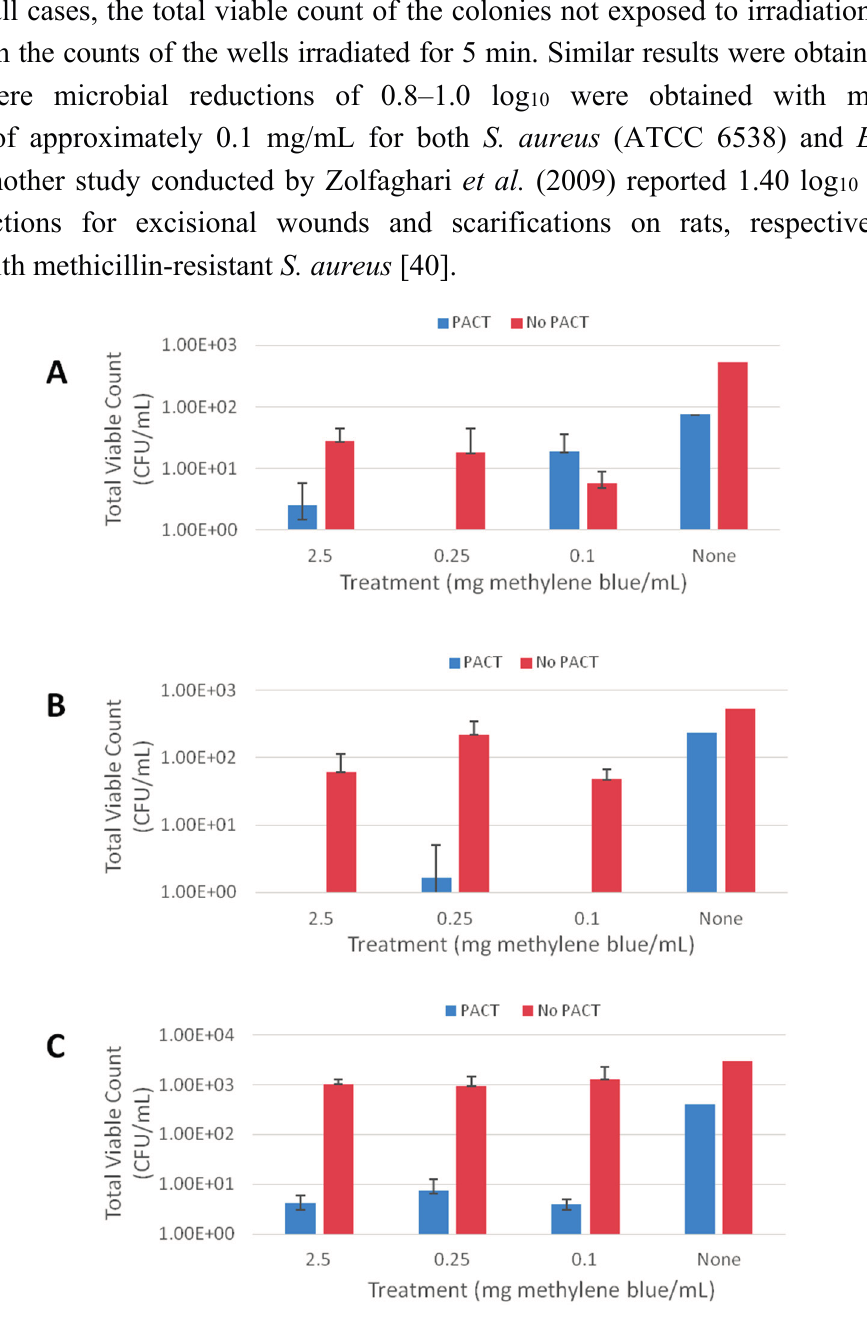
Figure 4. Effect of exposure to photodynamic antimicrobial chemotherapy (PACT) at a range of methylene blue concentrations on killing of biofilm grown strains ( A ) S. aureus , ( B ) E. coli and ( C ) C. albicans (Means ± S.D., n =